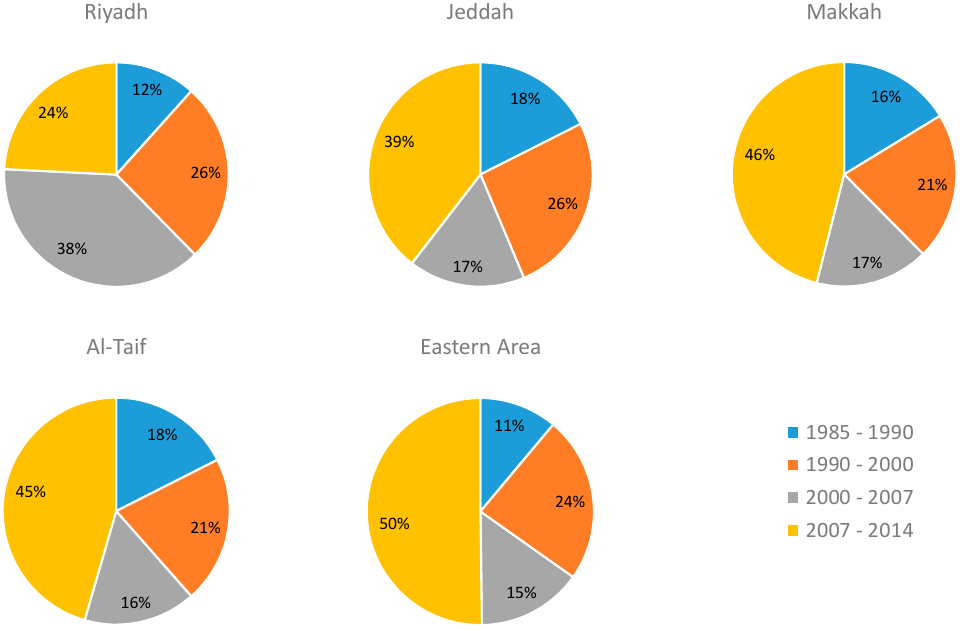
Figure 8. The differences in urban growth in percentage between the observation dates.